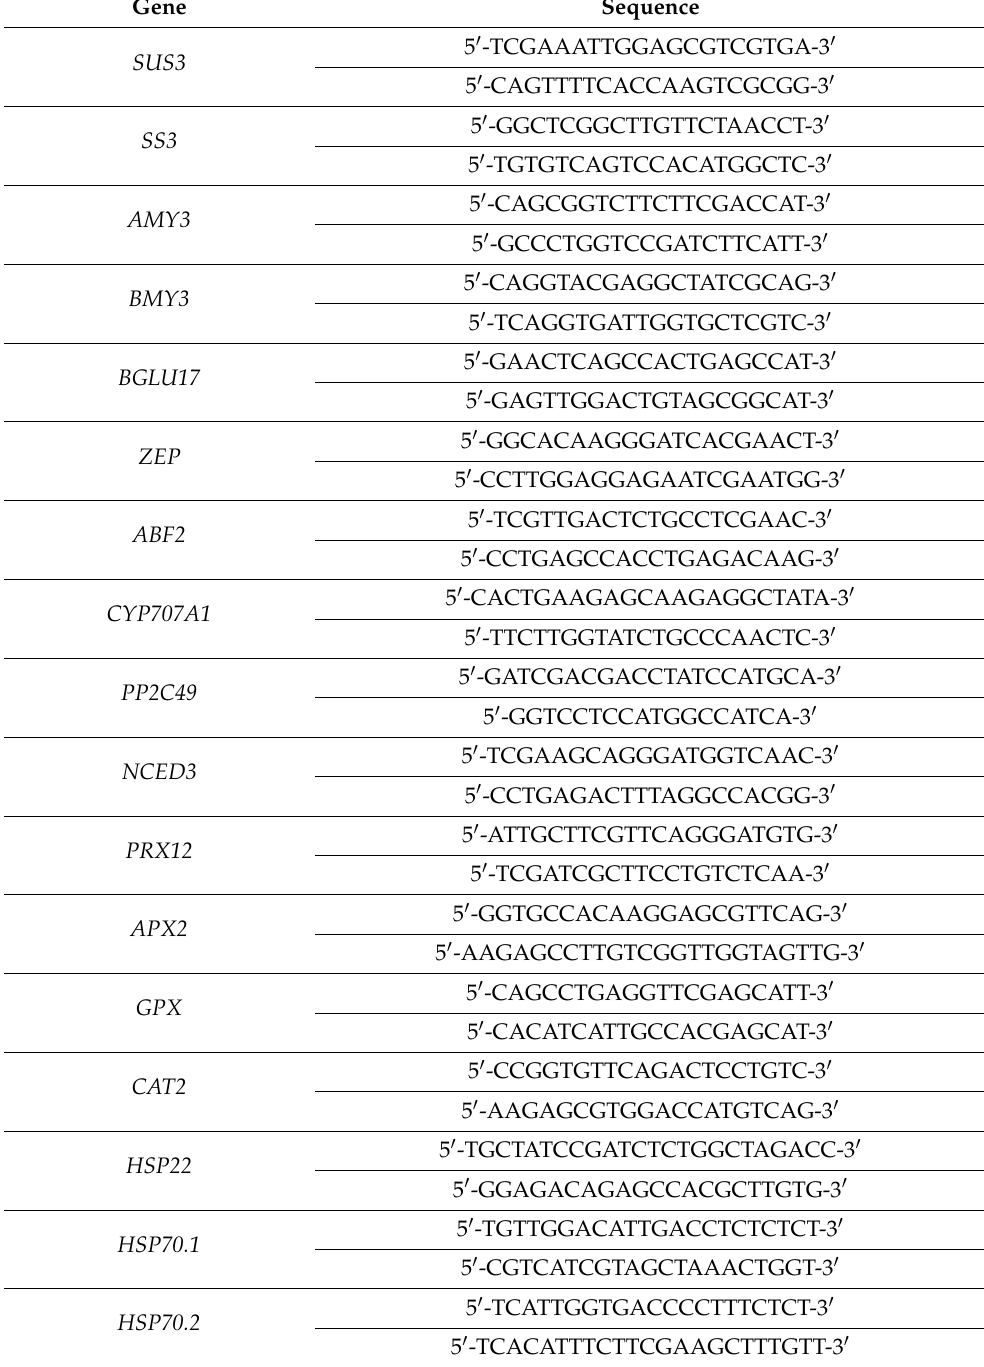
curve and normalized to the reference gene and control sample. Fold change was calculated ∆∆ CT using the standard 2 − method. Table 1. Sequences of the primer pairs used for the real-time PCR analysis.